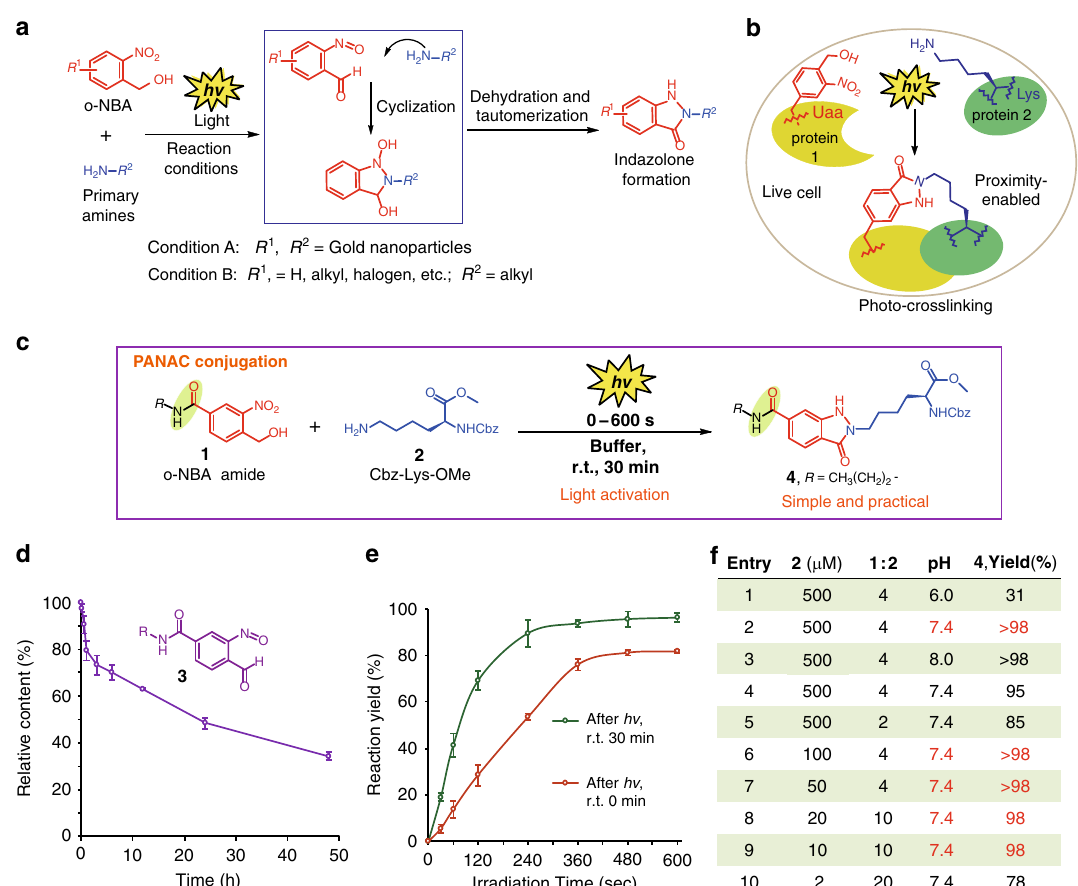
Fig. 2 Identi fi cation of o -NBA amide and optimizing conditions for light-induced PANAC conjugation. a General scheme for previous reported light- induced indazolone formation. b The residue-selective photo-crosslinking approach to capture protein – protein interactions in living cells based on proximity-enabled indazolone formation. c PANAC conjugation of primary amine 2 with o -NBA amide 1 . d The stability of the intermediate aryl-nitroso 3 photogenerated from 1 in neutral buffer (100 mM PBS/MeOH = 2:1, pH = 7.4), data are shown as mean ± SEM ( n = 3 independent experiments). e The reactions proceeded smoothly after hundreds seconds of light activation (red line), a further incubation of the reaction mixtures to give increasing yields (green line), data are shown as mean ± SEM ( n = 3 independent experiments). f Optimization of reaction conditions. Yields were determined by ratio of peak area value of experiment to that of internal standard product on reverse-phase HPLC, are reported as an average of three independent trials, see Supplementary Information. With scale of 0.1 mmol ( 2 , 2 mM, 1 : 2 = 4) in f of entry 2, the reaction provided 4 with 90% isolated (Uaa, o -NBAK) and ε -amino group of proximal lysine in living cells upon light activation 41 . However, this indazolone formation